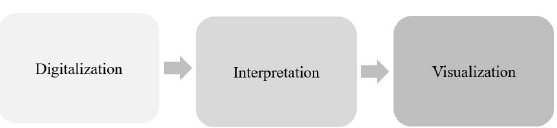
Figure 1. The knowledge process for archaeological